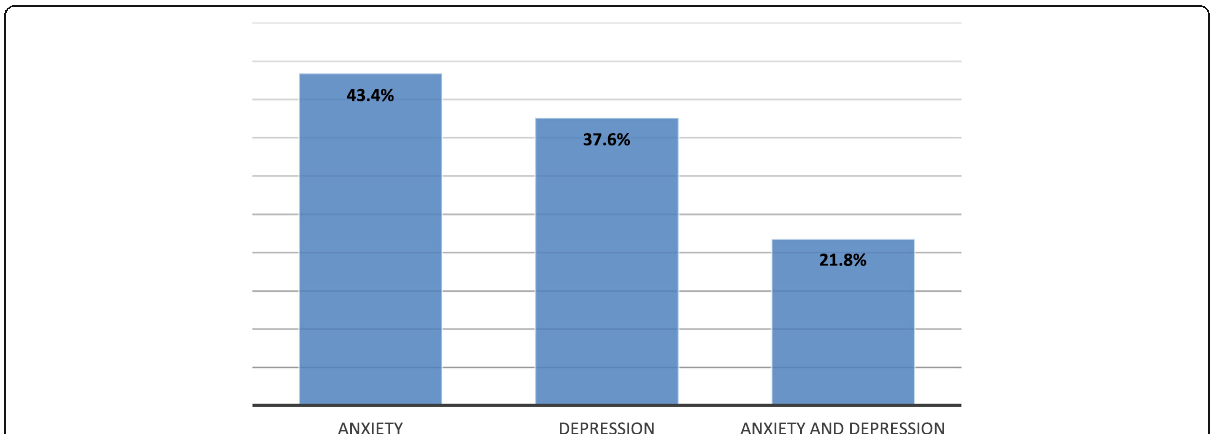
Fig. 3 Frequency of anxio-depressive disorders at the time of the first consultation (the total does not sum up to exactly 100% because of multiple